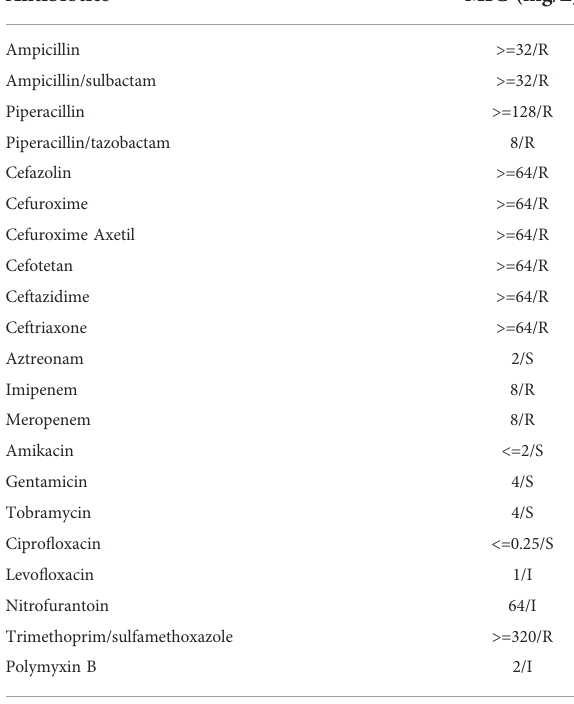
TABLE 1 Antimicrobial drug susceptibility pro fi